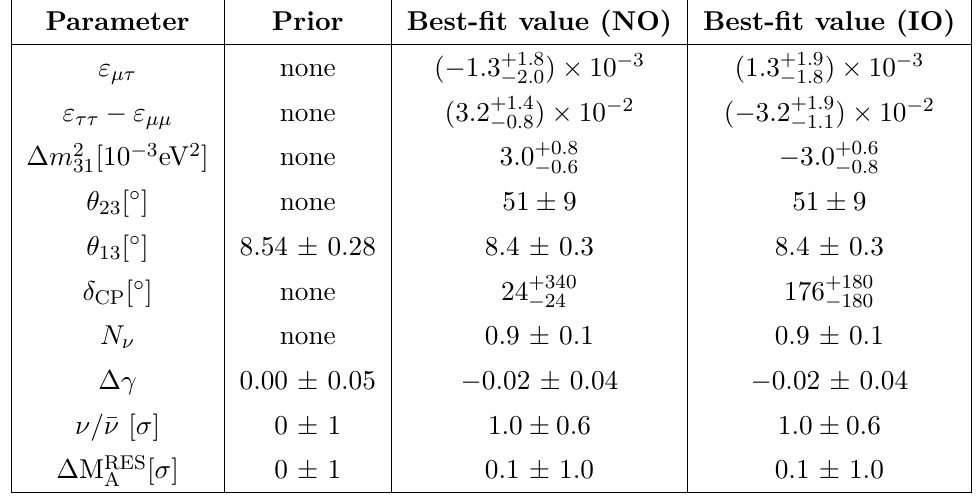
Table 1 . List of free parameters used in the maximisation of the likelihood ratio, their priors and the best-fit values for the case of NO and IO